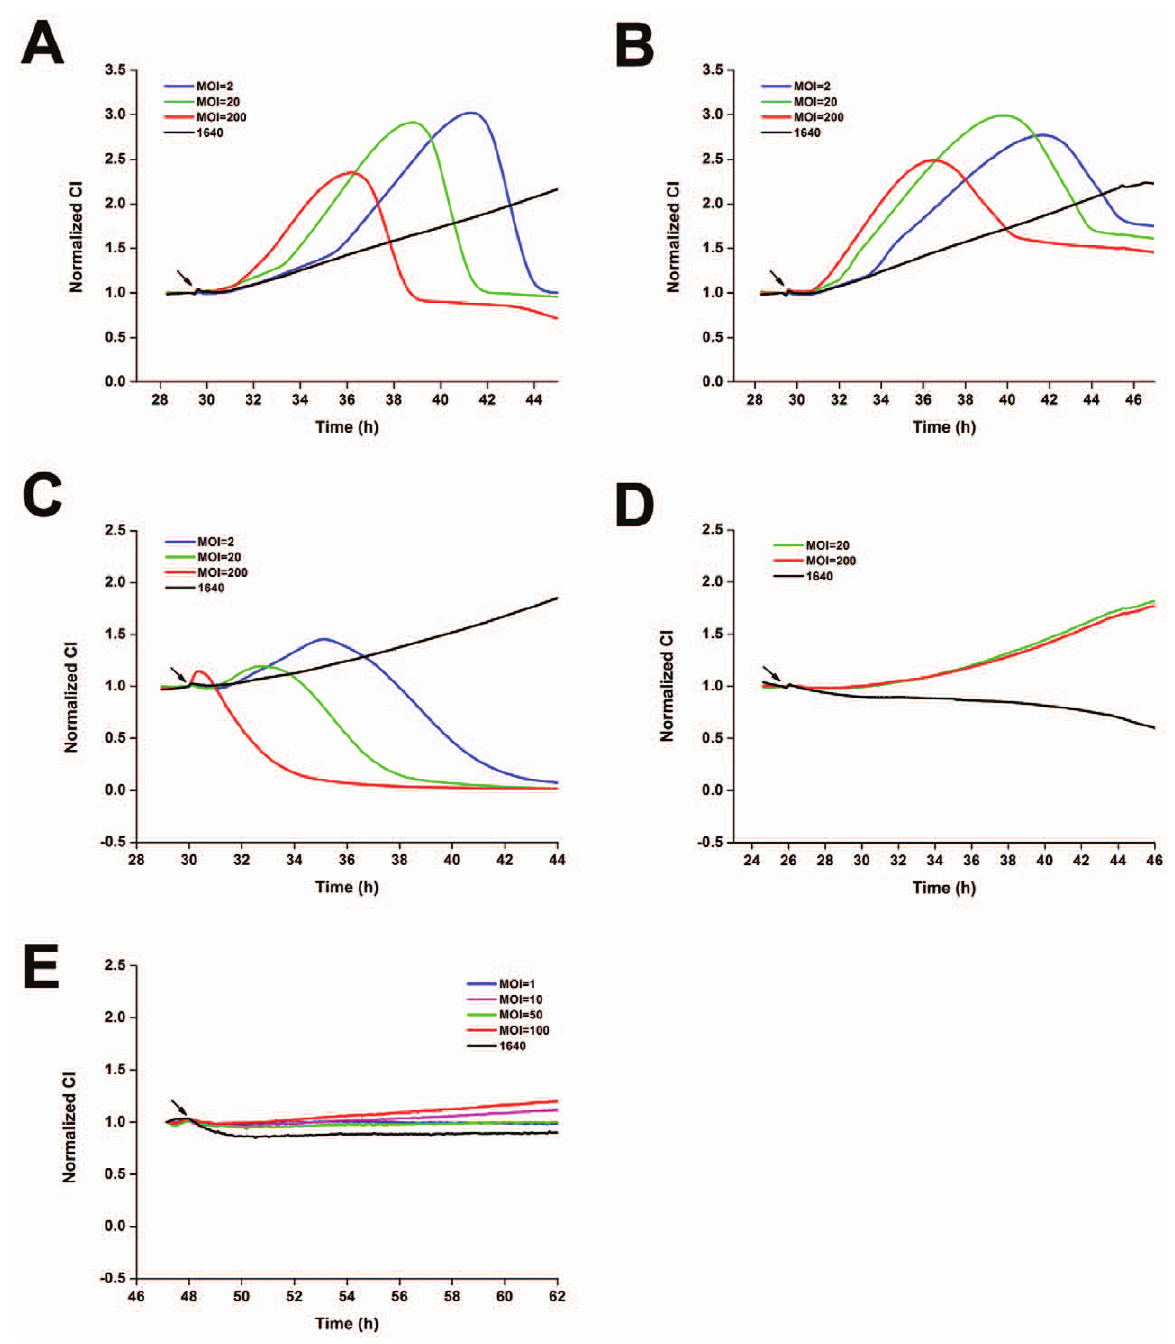
Figure 5. Dynamic monitoring of intestinal epithelial cell responses to intestinal bacteria. HT-29 cells (10,000 cells per well) were seeded into E-plates. The next day, cells were infected with Y. enterocolitica (A), S. flexneri (B), L. monocytogenes (C), E. coli DH5 a (E), and Lactobacillus (F). Arrows, bacterial addition. Representative curves are an average of four replicate wells.